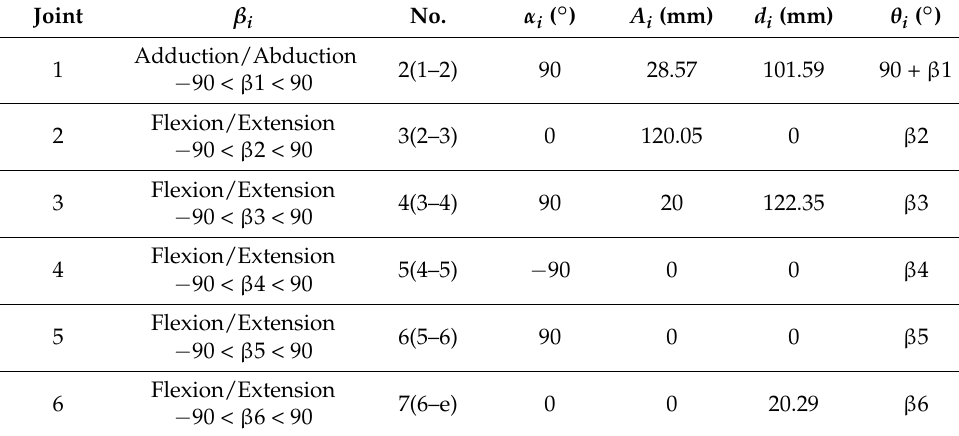
Table 2. Degree of joints in D-H coordinates.